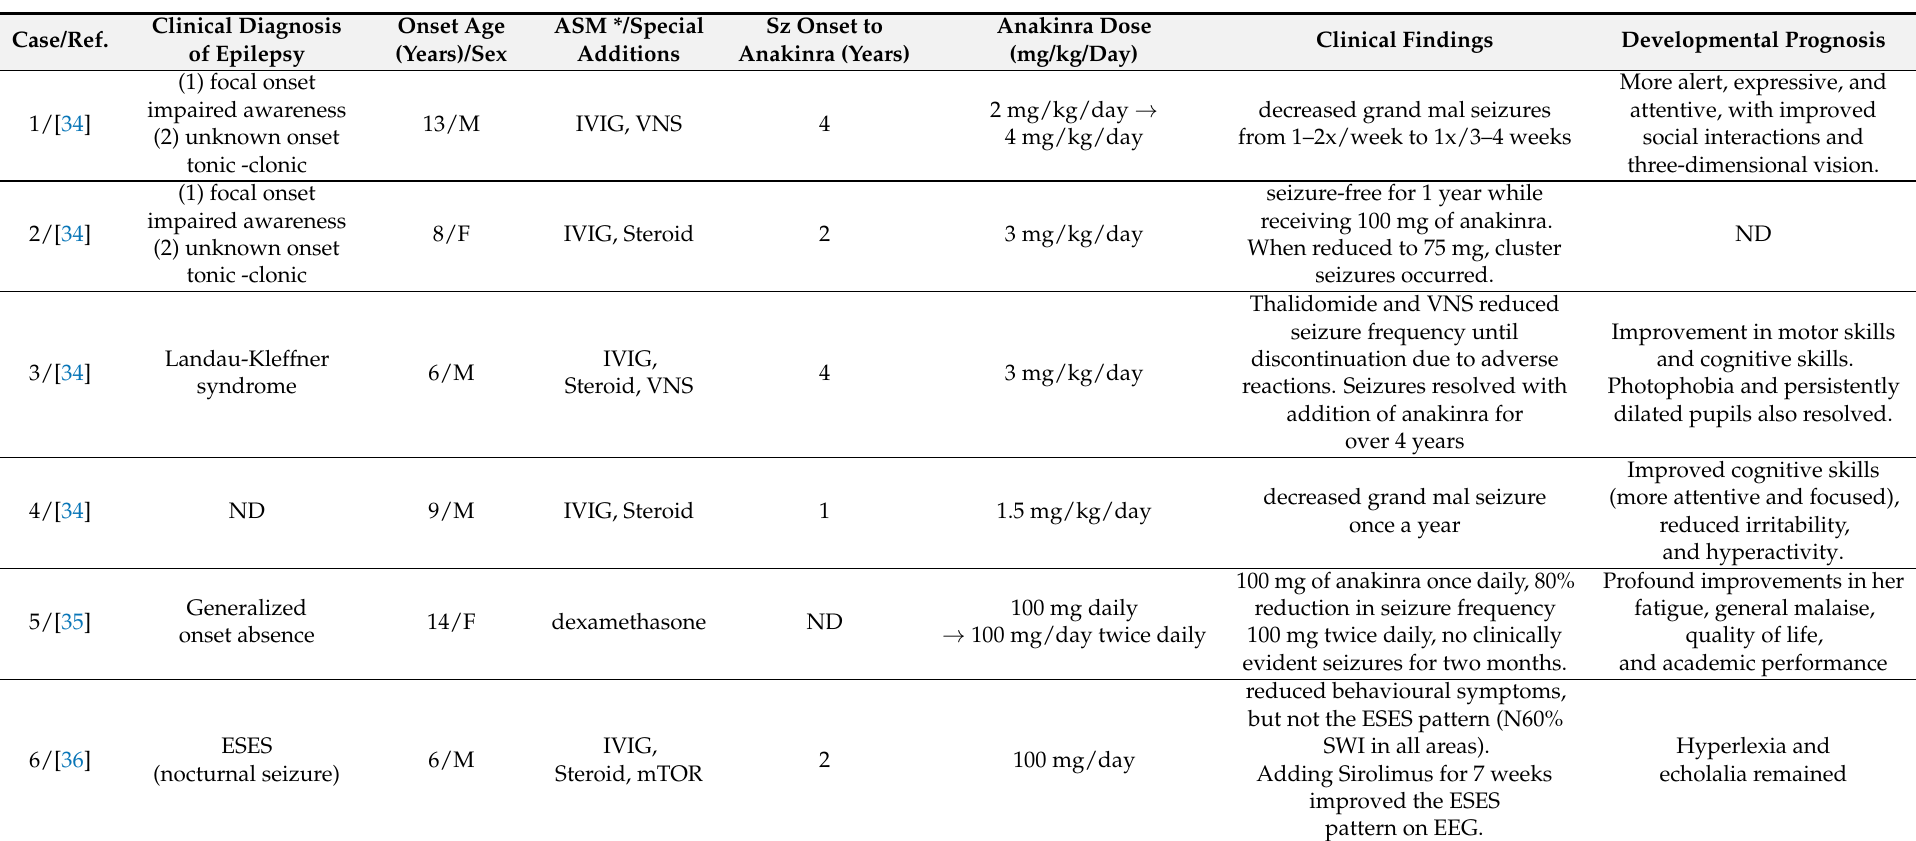
Table 2. Clinical features and treatment of drug-resistant